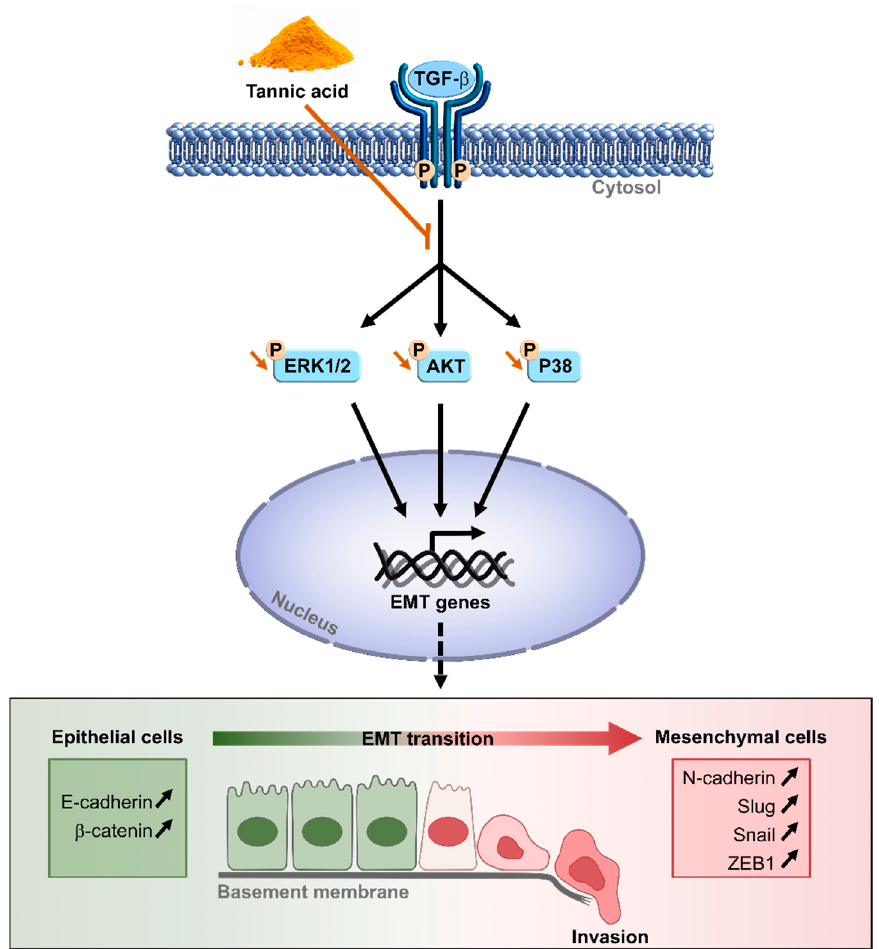
Figure 9. Tannic acid inhibits the epithelial–mesenchymal transition (EMT) of CRC cells by disrupt- ing TGF- β 1-mediated Smad-independent signaling pathways. Briefly, tannic acid decreases the phosphorylation of ERK1/2, AKT, and P38, and subsequently prevents invasion mediated by EMT. EMT is characterized by the occurrence of morphological and phenotypic changes